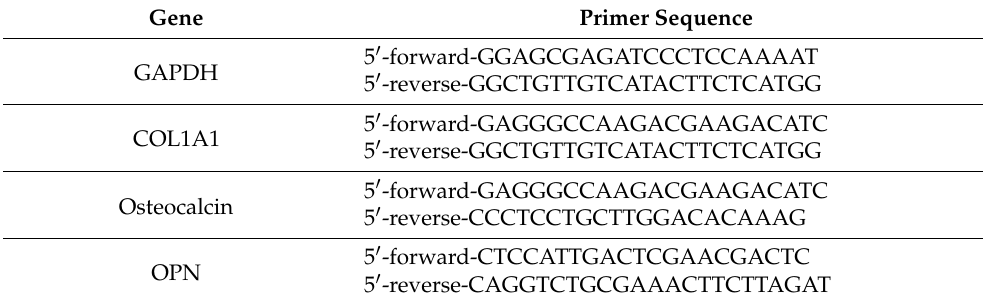
Table 1. Sequences of primers used for